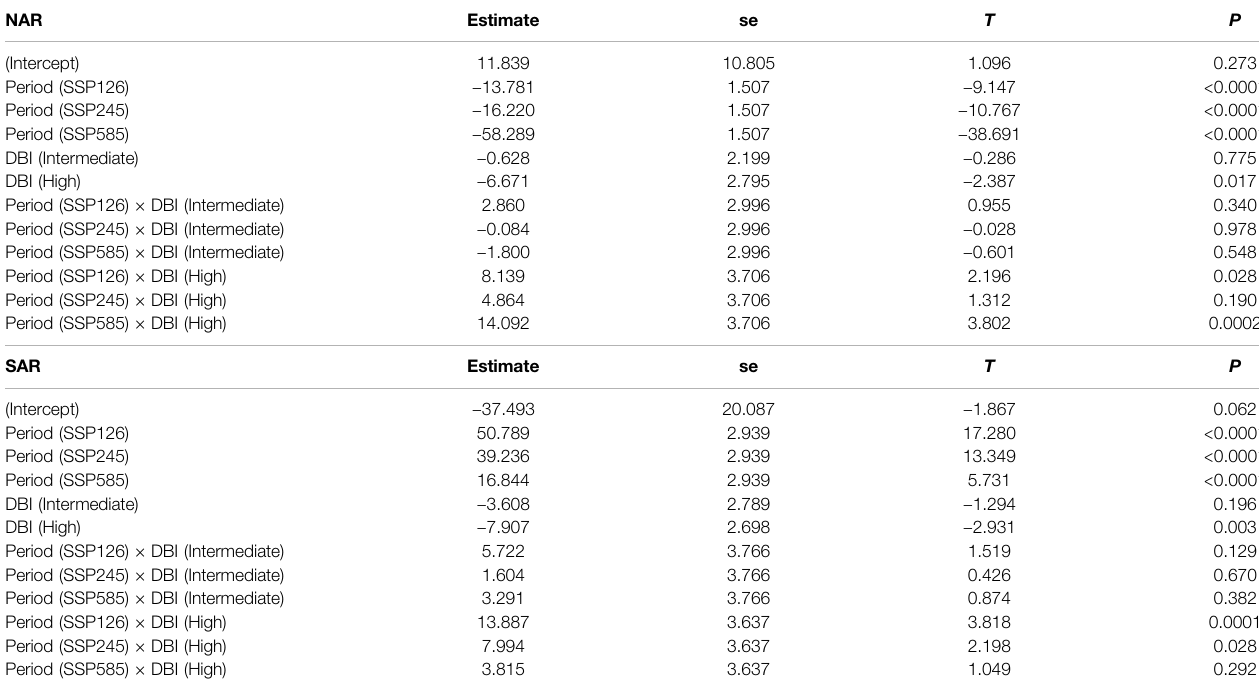
TABLE 2 | Summary statistics of the generalized least squares model assessing the difference in the change in annual precipitation across past and future periods in the surveyed localities of odonate assemblages with varying DBI levels in North African and South African regions. Past period and low DBI are used as baseline levels. R-squared was 0.43 in NAR and 0.21 in SAR.